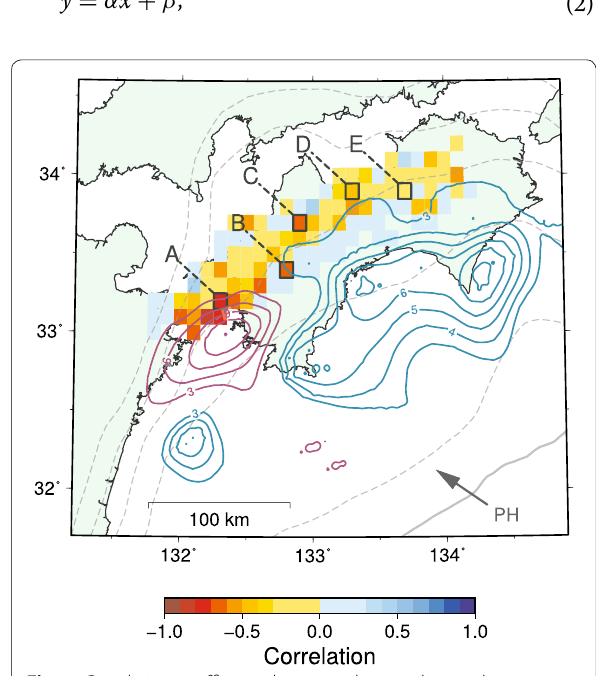
Fig. 4 Correlation coefficients between the coupling and tremor count rates in each grid. Red and blue contours are the same as in Fig. 1